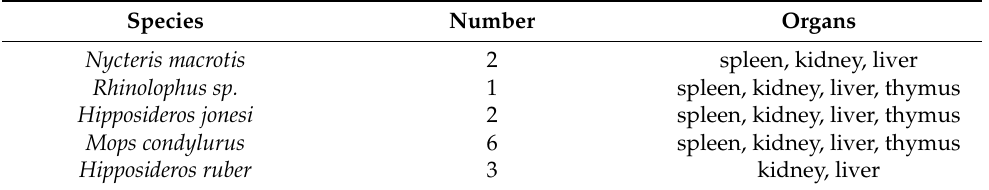
Table 2. Organs screened from bats on which necropsies were